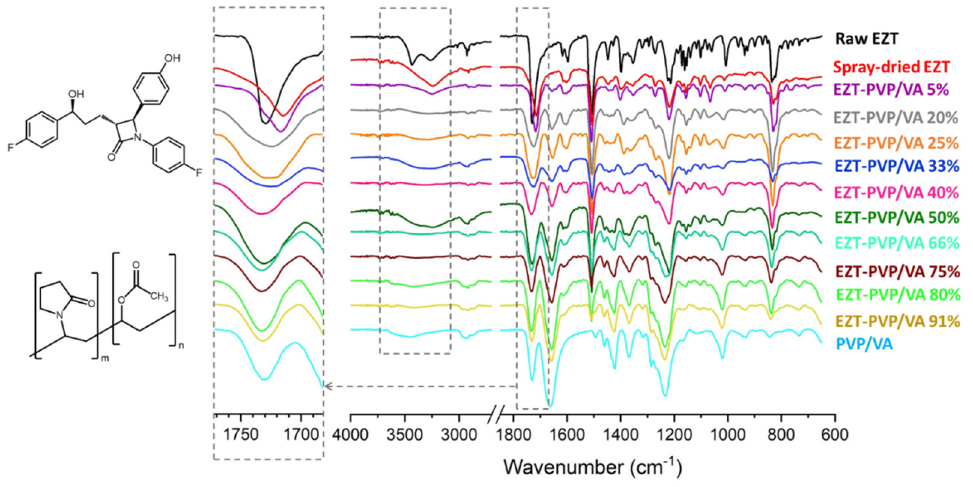
Figure 4. FTIR spectra of raw EZT, PVP/VA and EZT-PVP/VA solid dispersions. The shift in the peak position is visible while comparing crystalline and